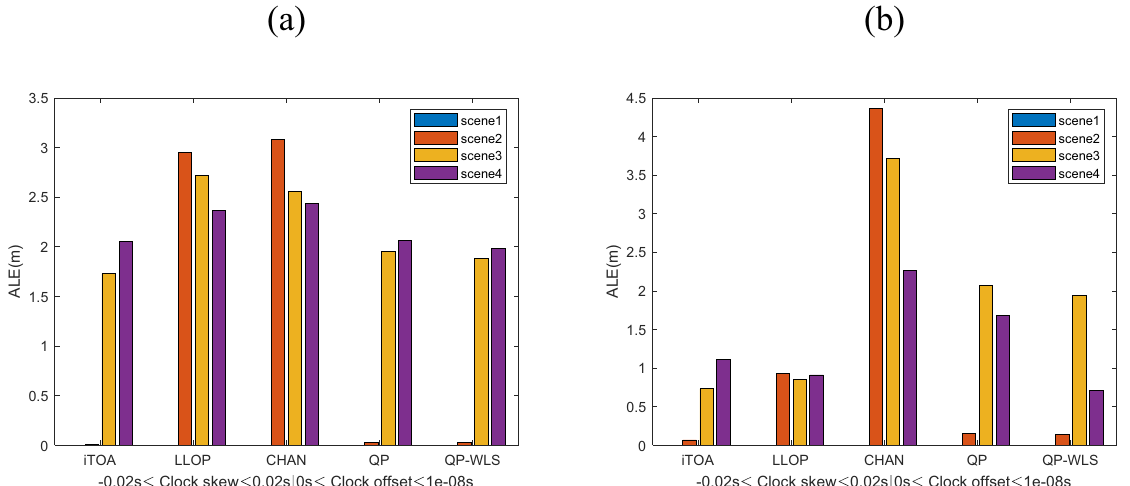
Figure 6: Average positioning error diagram of each algorithm when the proportion of time synchronization error and NLOS error is di ff erent. ( a ) The proportion of time synchronization error is 0; ( b ) The proportion of time synchronization error is 0.3; ( c ) The proportion of time synchronization error is 0.5; ( d ) The proportion of time synchronization error is